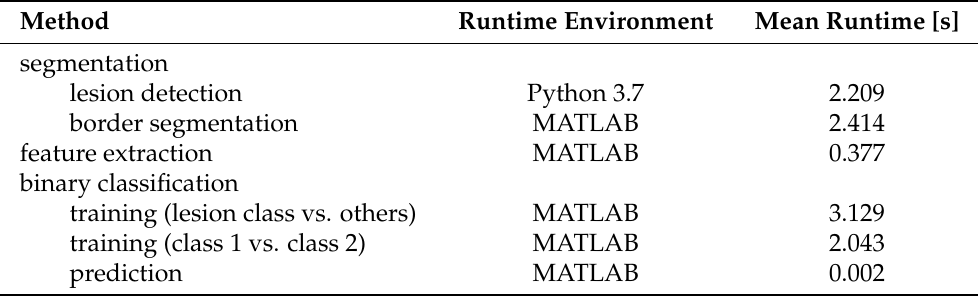
Table 6. Runtime measurements of the proposed algorithm. For segmentation and feature extrac- tion, the mean runtime over all images; for classification tasks, the mean runtime over all folds was